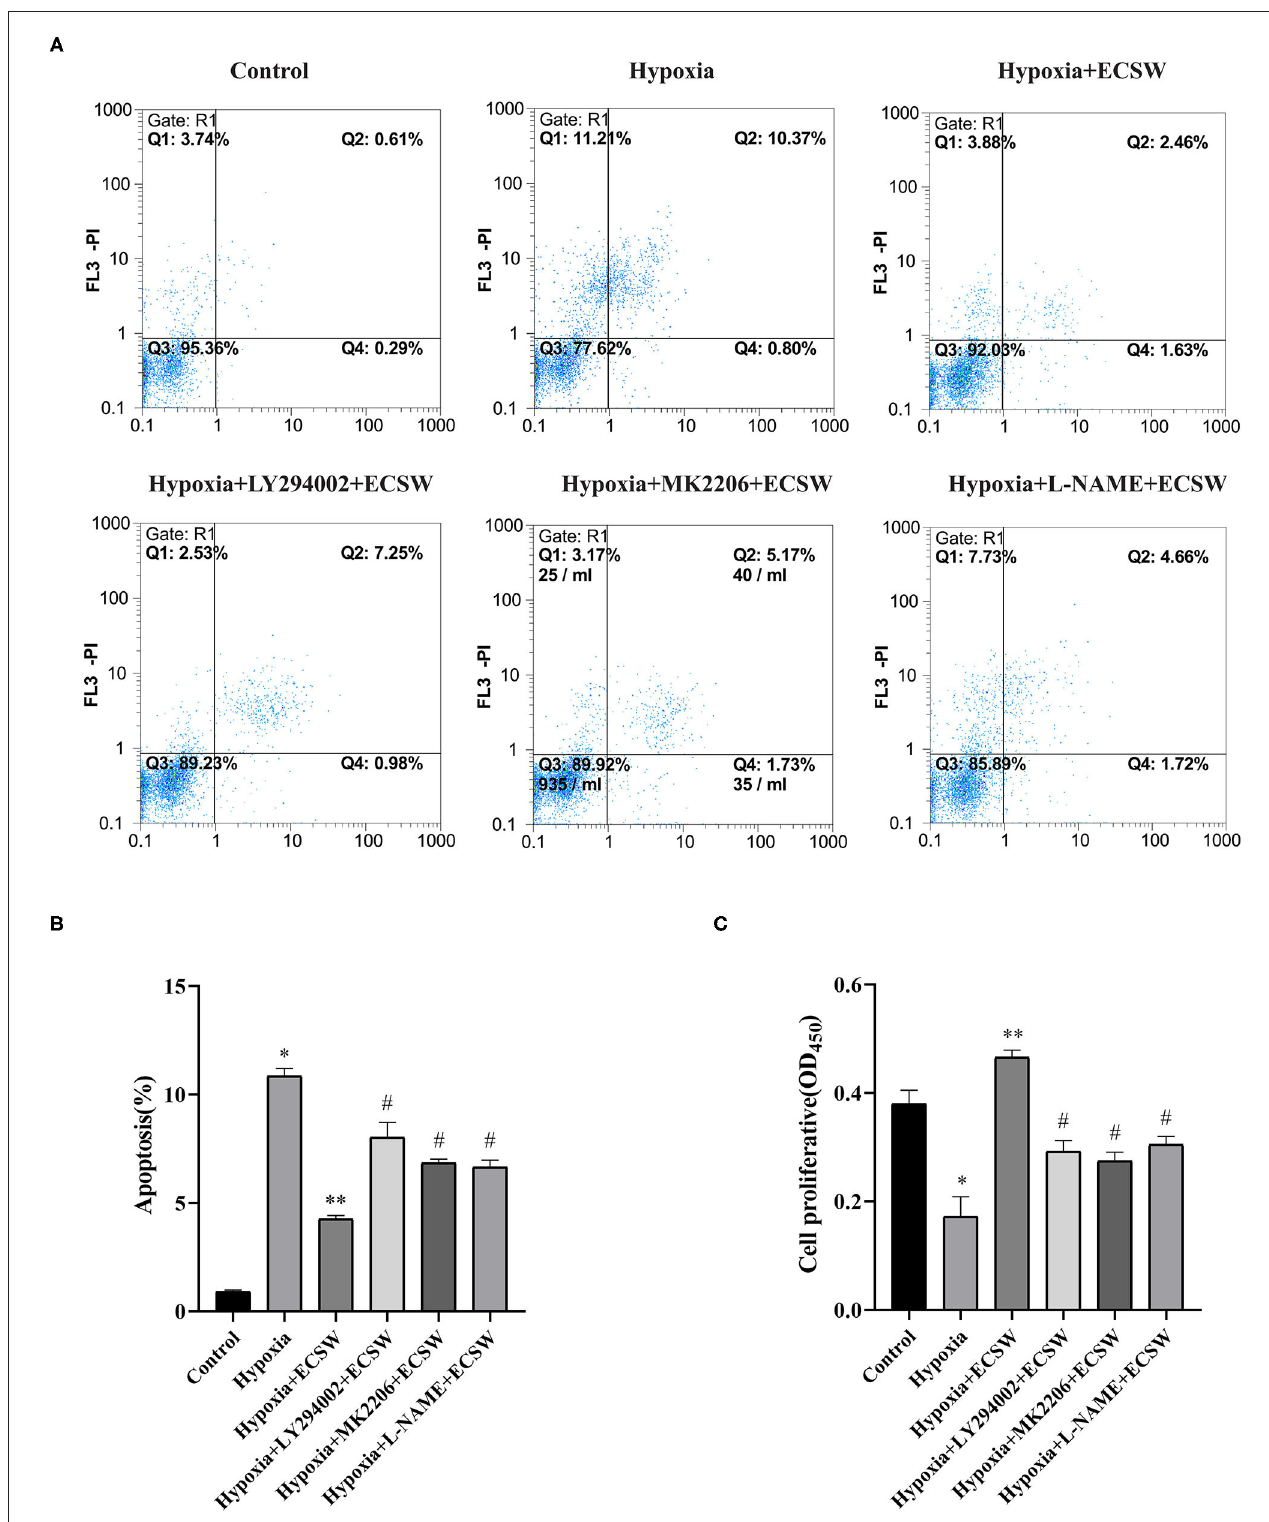
FIGURE 3 | Extracorporeal cardiac shock waves (ECSW) inhibit apoptosis and promotes the proliferation of EPCs after hypoxic injury by activating PI3K/Akt/eNOS signaling pathway. (A) Representative images of EPC apoptosis in each group were detected using flow cytometry. (B,C) Quantitative analysis of the apoptosis of EPCs and the proliferation of EPCs in each group, respectively. Data are presented as mean ± SD, N = 3. * P < 0.05 vs. group control, ** P < 0.05 vs. group hypoxia, # P < 0.05 vs. group hypoxia + ECSW.